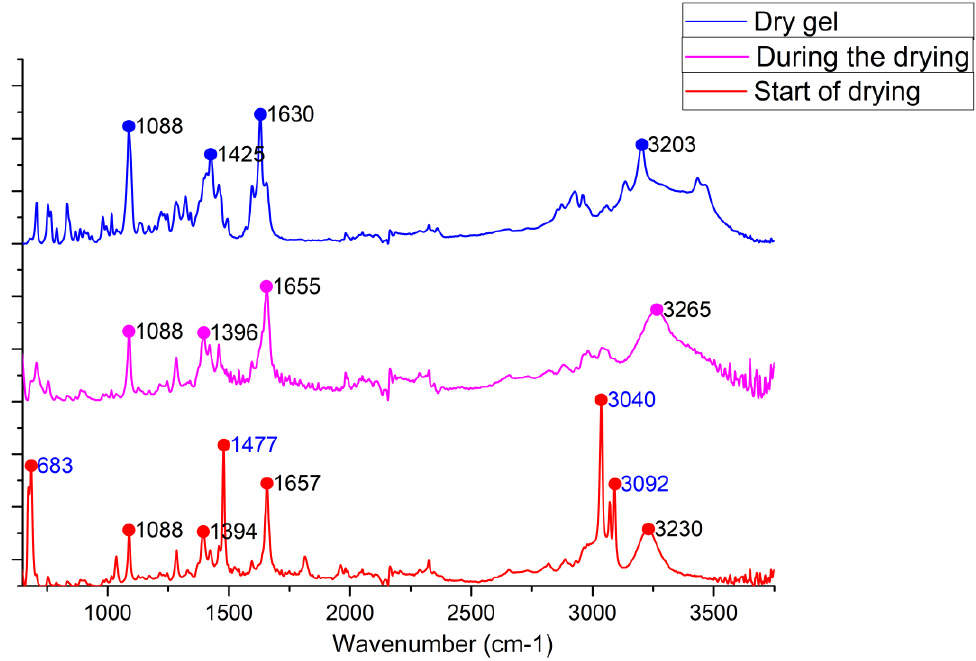
Figure 5. The changes in ATR spectra of 4ab during solvent removal. Benzene peaks are shown in blue. See text for details.